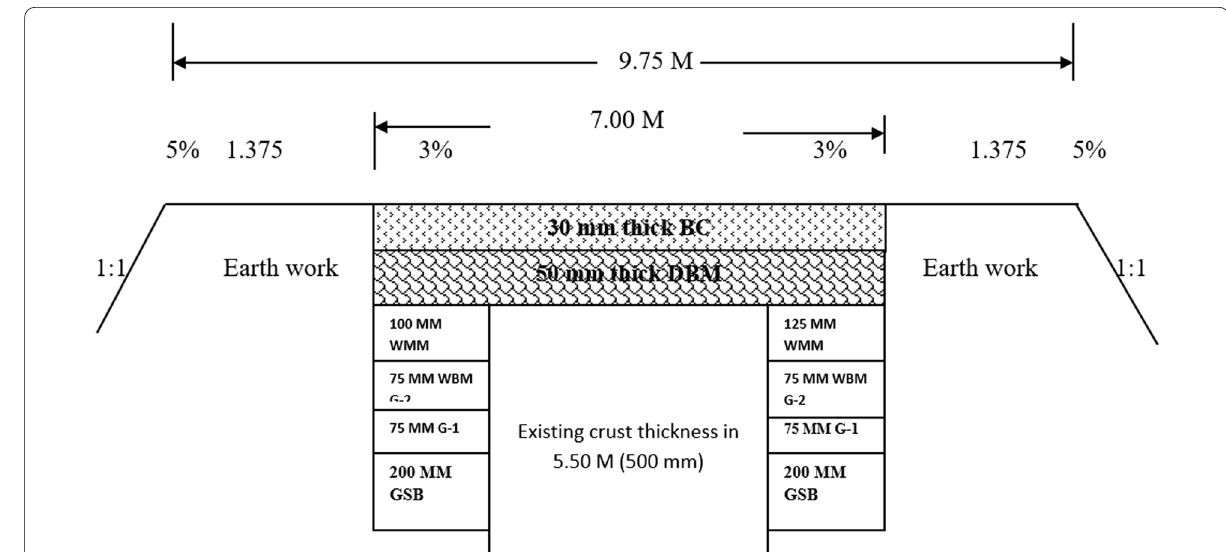
Fig. 7 Cross section of Alewa-Rajound